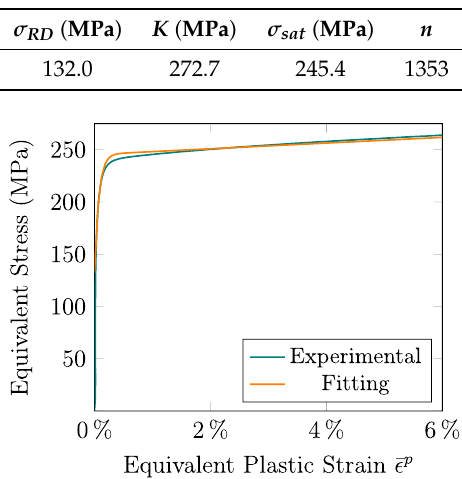
Table 2. Parameters of the hardening function.